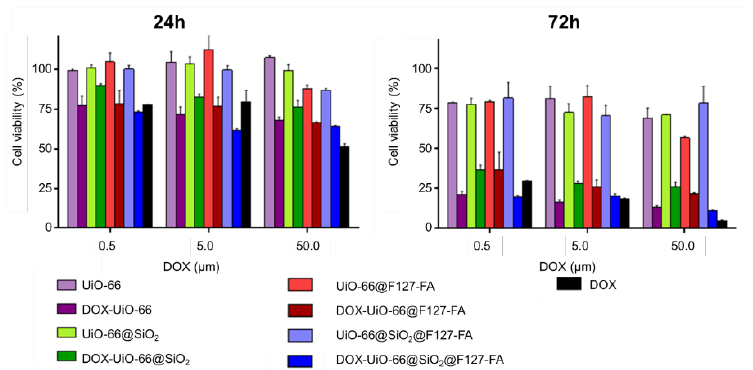
Figure 9. Cytotoxicity of the blank MOFs, DOX-loaded MOFs, and free DOX for MCF-7 cells